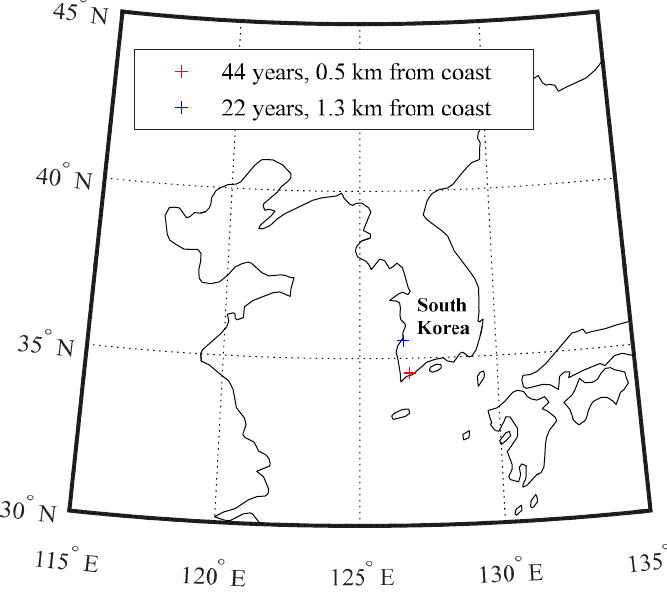
Figure 7. Geographical locations of two concrete bridges for in situ data acquisition .